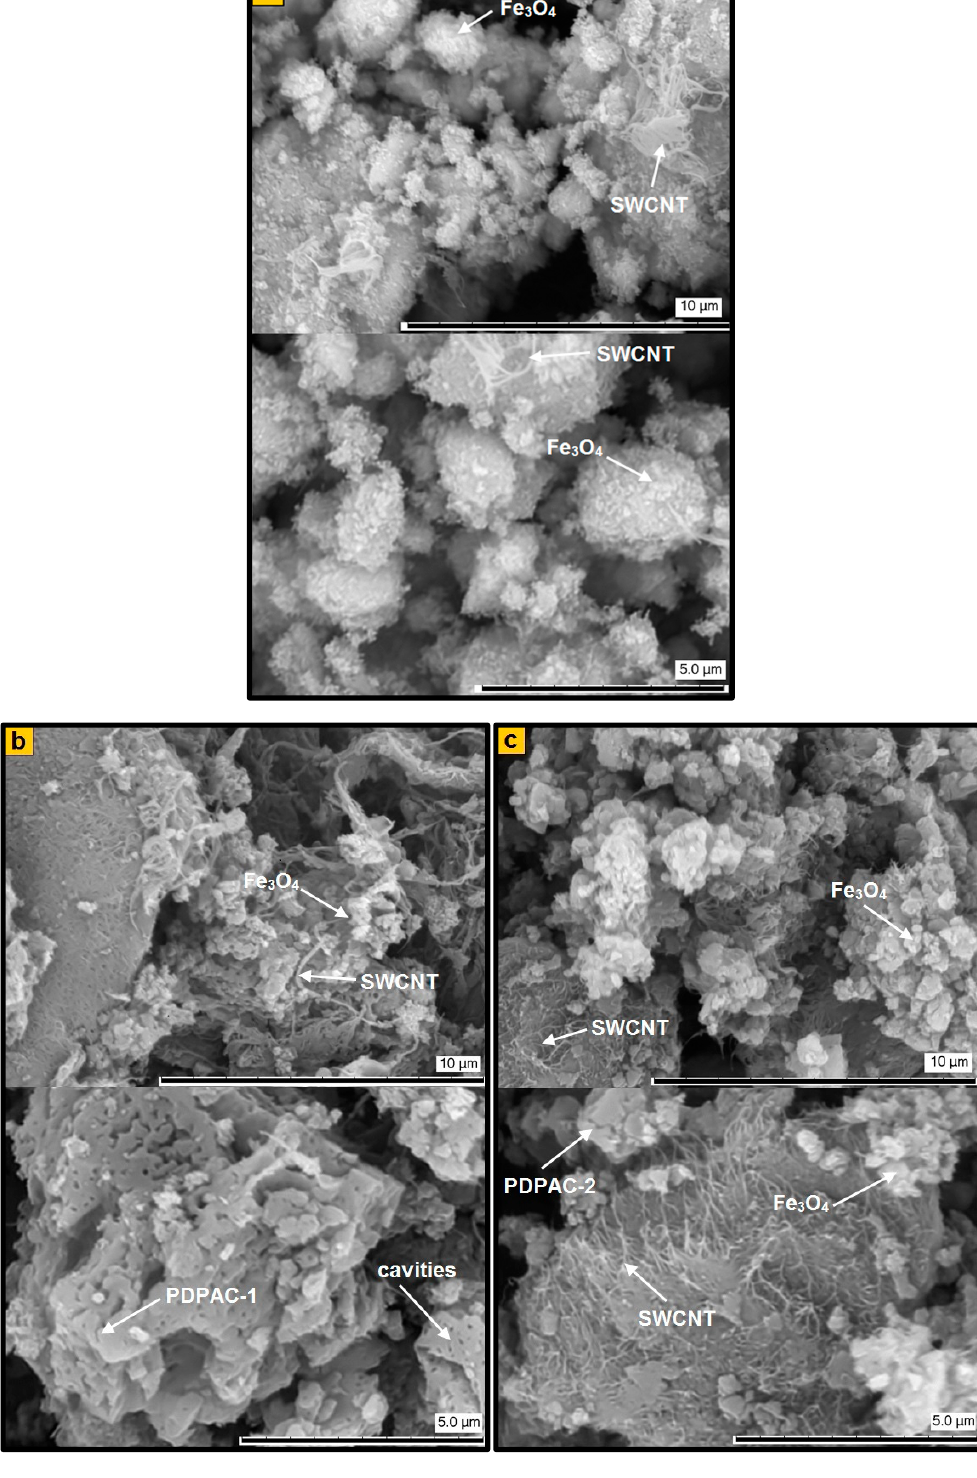
Figure 5. SEM images of Fe 3 O 4 /SWCNT ( a ) and Fe 3 O 4 /SWCNT/PDPAC, prepared in alkaline ( b ) and acidic media ( c ).